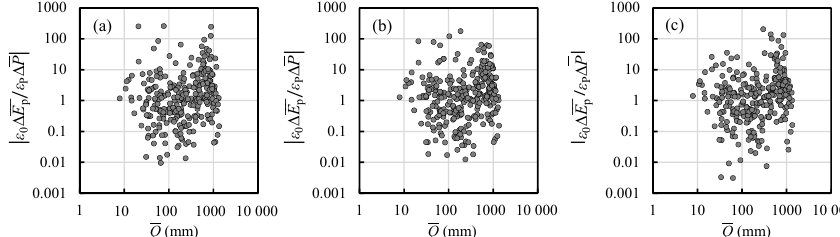
Figure 13. Analysis of the controlling factor in the projected climate change under (a) RCP2.6, (b) RCP4.5, and (c) RCP8.5 scenarios.